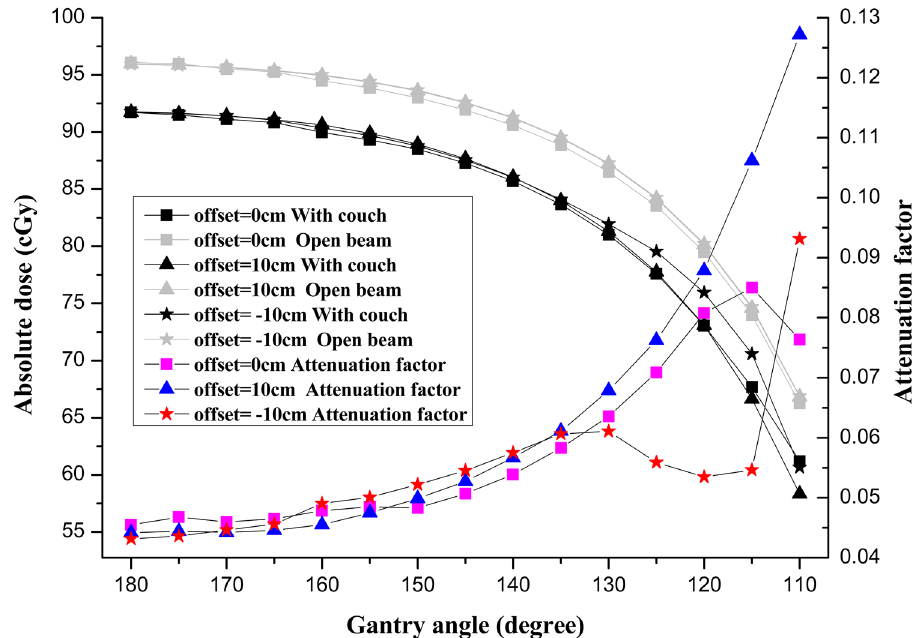
Figure 5. The attenuation profiles with the treatment couch at different